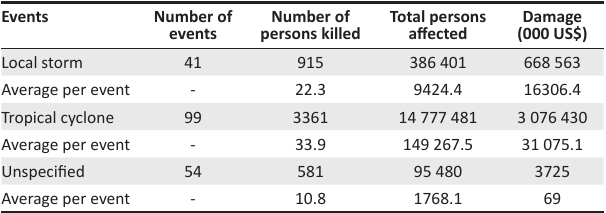
TABLE 1: Storm profile on the African continent,